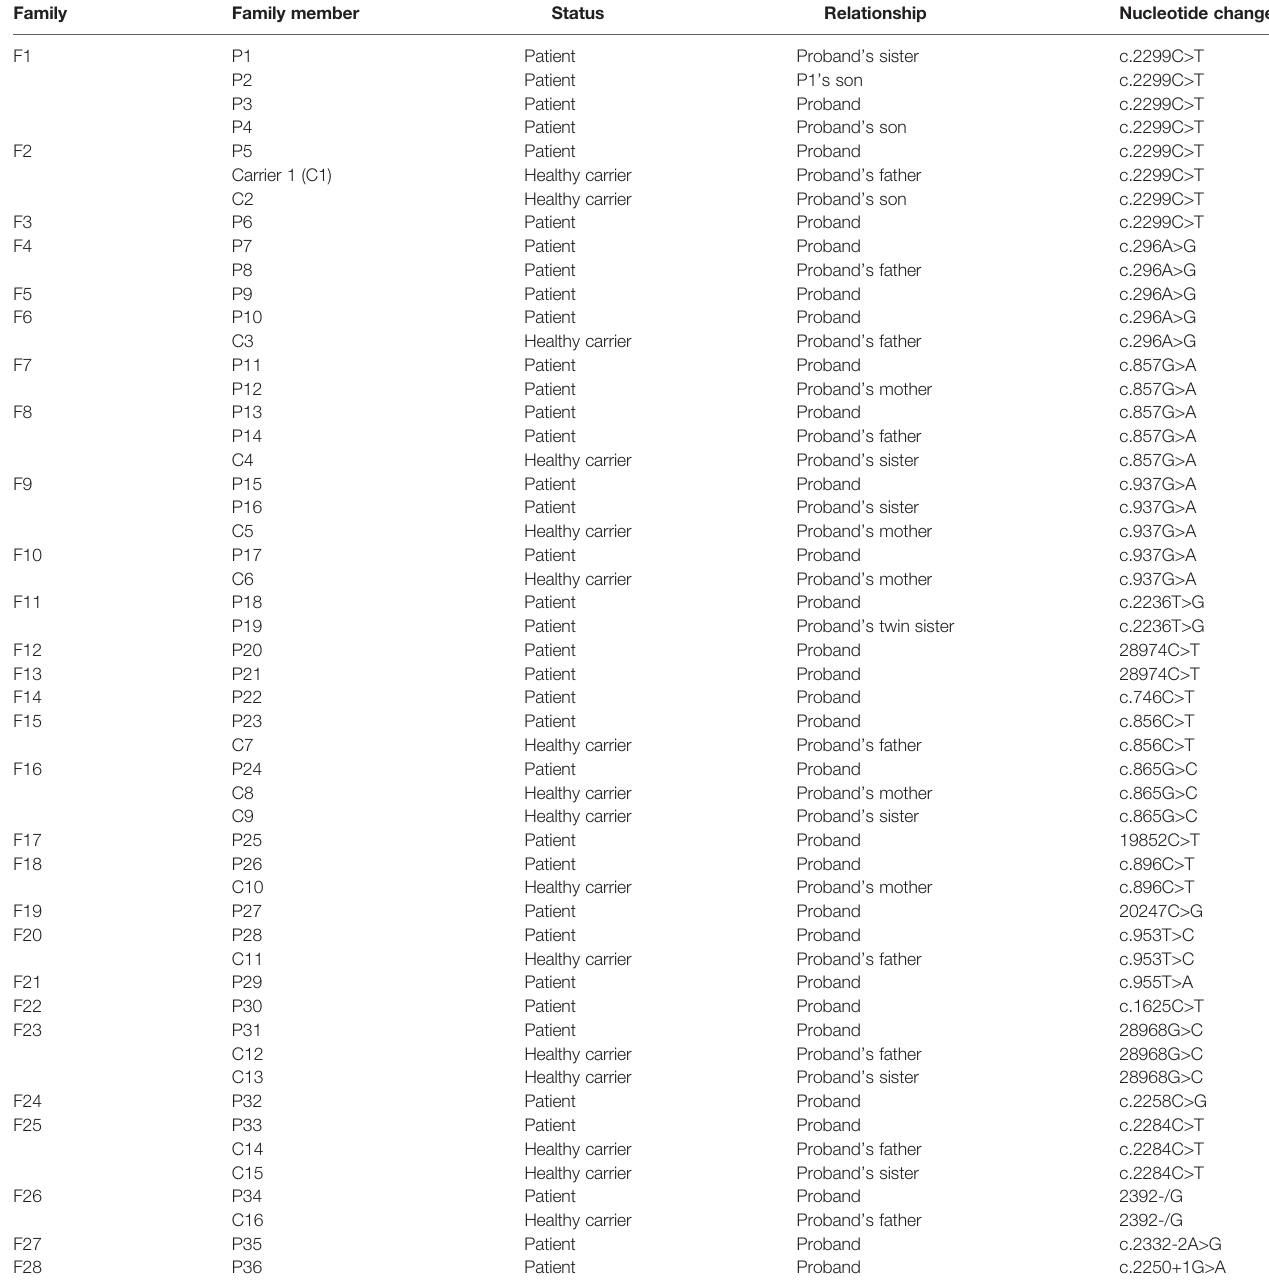
TABLE 1 | CLCN7 mutation in ADO II families. Family Family member